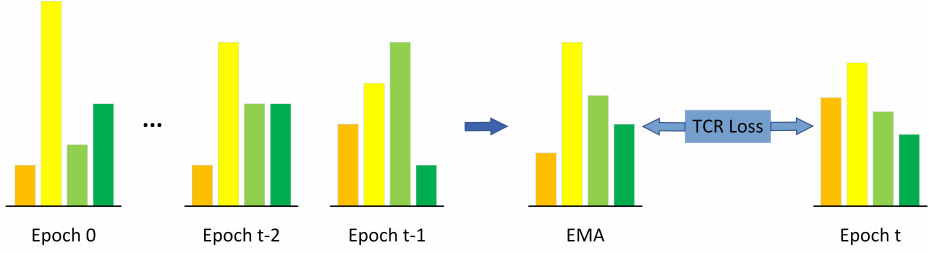
Figure 5. Illustration of the temporal consistency regularization (TCR) module. We record the exponential moving average of the past predicted distributions (logits), which serve as the soft targets for the current